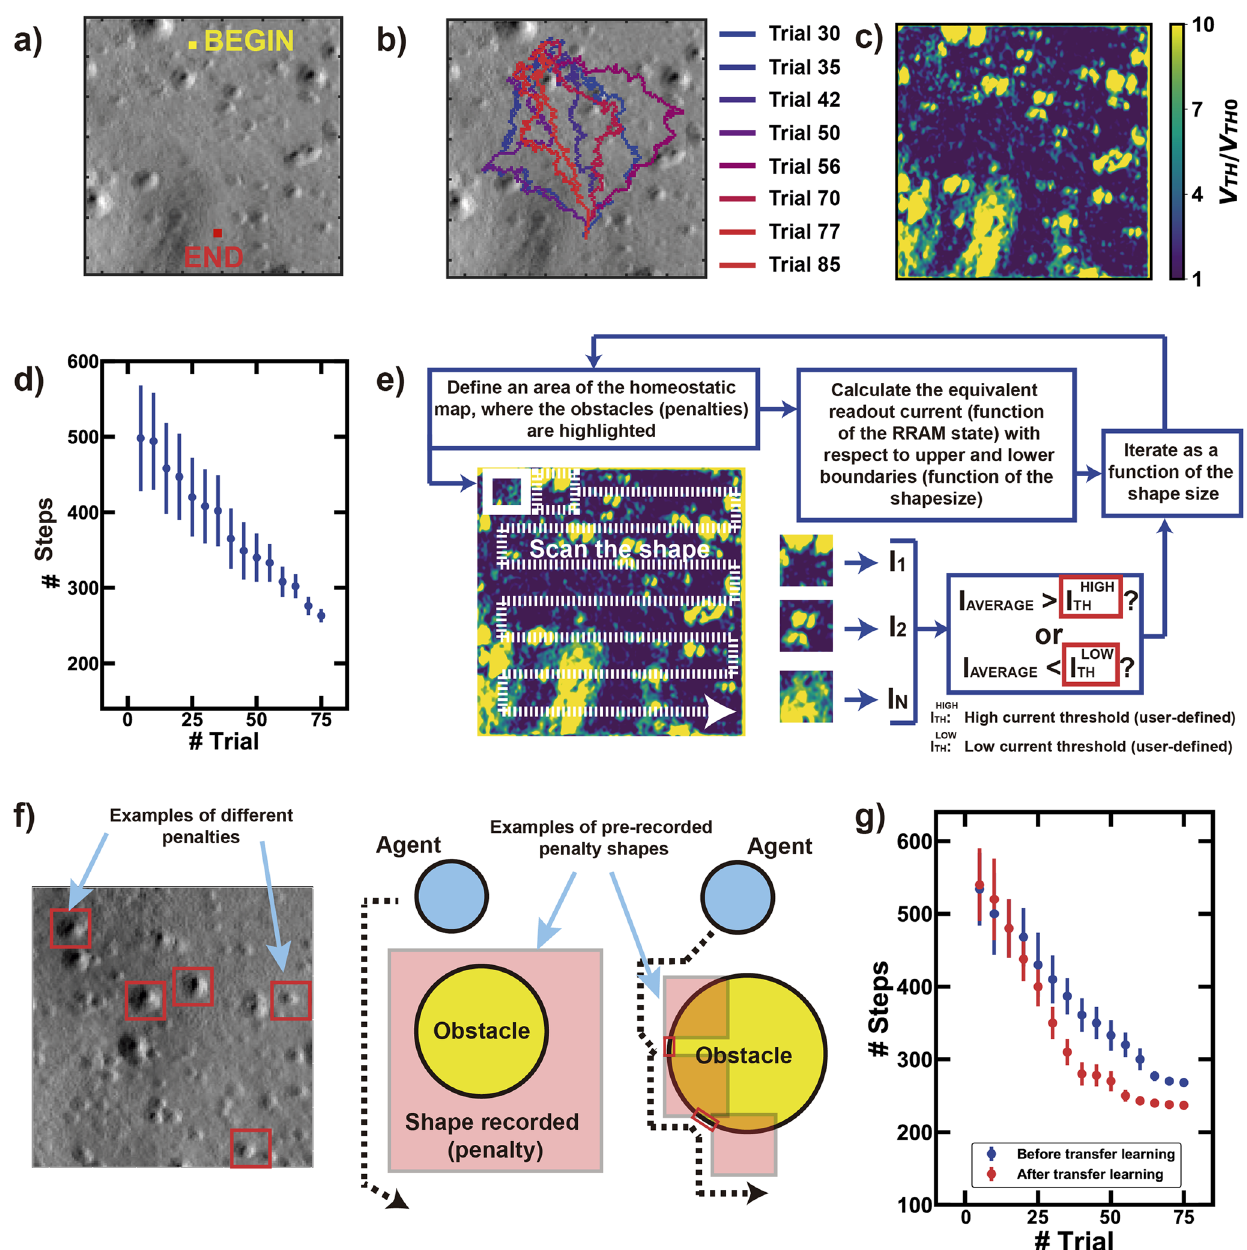
Fig. 5| Recon fi gurabilityand scalabilityofthe hardwareunder the MarsRover navigation test. a Custom environment of Mars readapted from HiRISE, with highlighted the initial (start) and the fi nal (global reward) points selected for the testofthealgorithm. b Theagentexplorestheenvironmentin100trials,eventually fi nding the target: note that the successful trials improve the strategy step-by-step to getfaster to the solution. c Various trials of explorationleadto the creation of a complete policy map of the whole environment, with higher equivalent threshold of the positions which received penalties. d Time improvement of the exploration path: after selecting a starting point, the policy map drives the system to